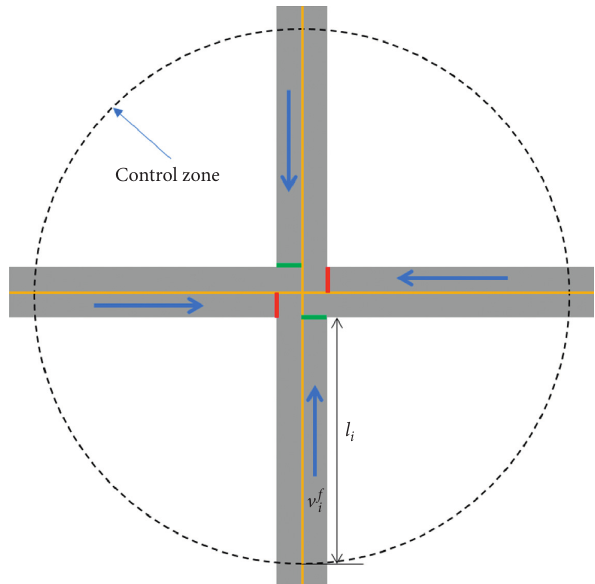
Figure 1: A simple intersection with four arms.